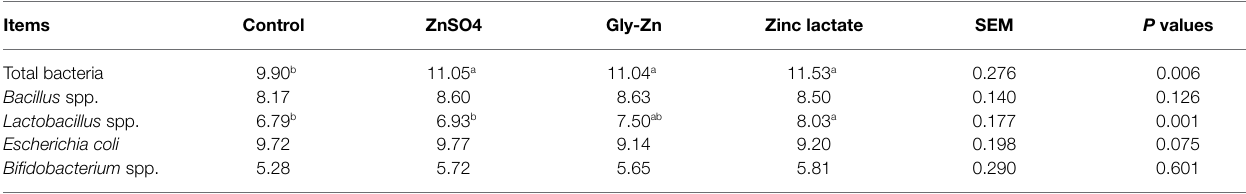
TABLE 7 | Effect of dietary zinc source on the numbers of Escherichia coli , Lactobacilli spp . , Bifidobacterium spp ., and Bacillus spp. in the cecal digesta of weaned piglets (log [copies/g]). Items